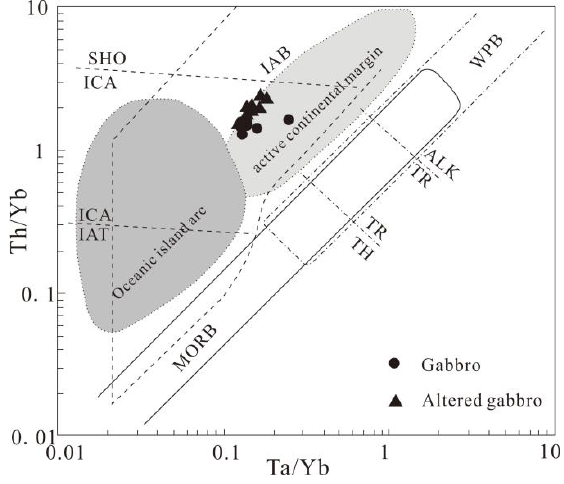
Figure 9. Ba/Th versus Th/Nb discrimination diagram for Ping’an gabbros.